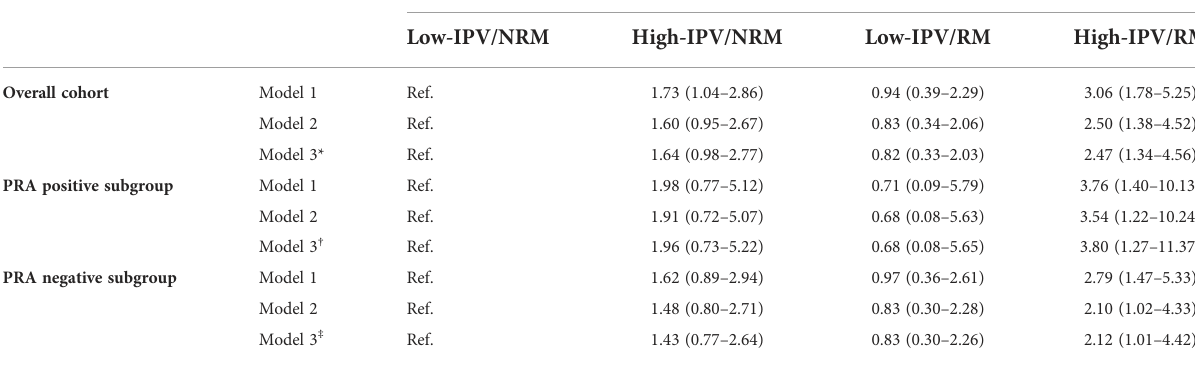
TABLE 5 Multivariate Cox proportional hazard regression model analysis for